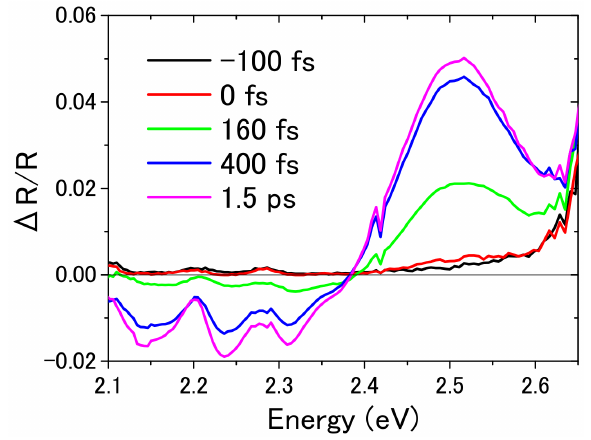
Figure 10. Experimental ∆ R/R spectra after excitation of plasmons in the Au film.